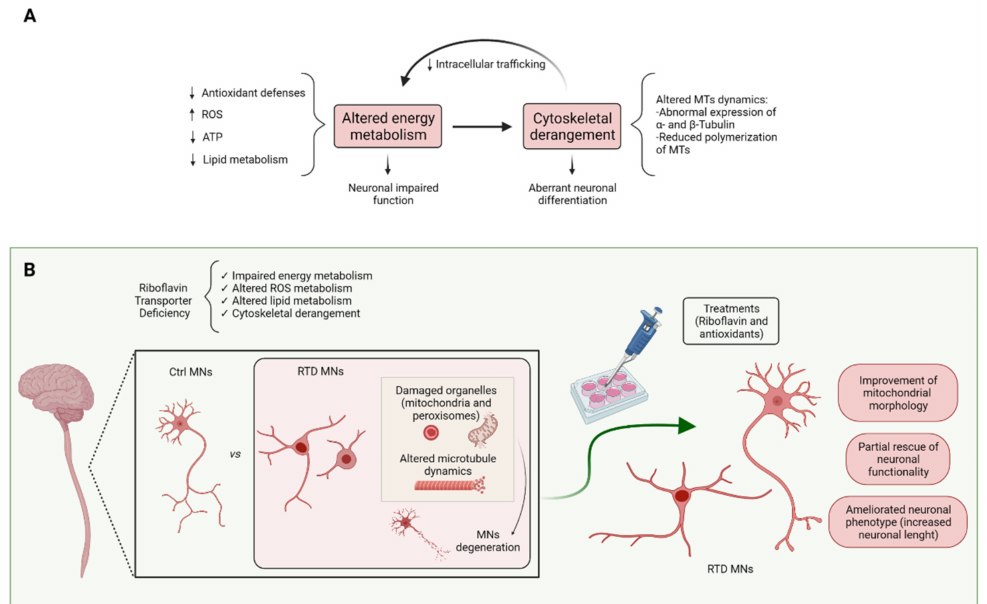
Figure 3. ( A ). As a precursor of FMN and FAD, RF plays a crucial role in energy metabolism. Deficiency of RF transporters leads to mitochondrial and peroxisomal energy dysmetabolism